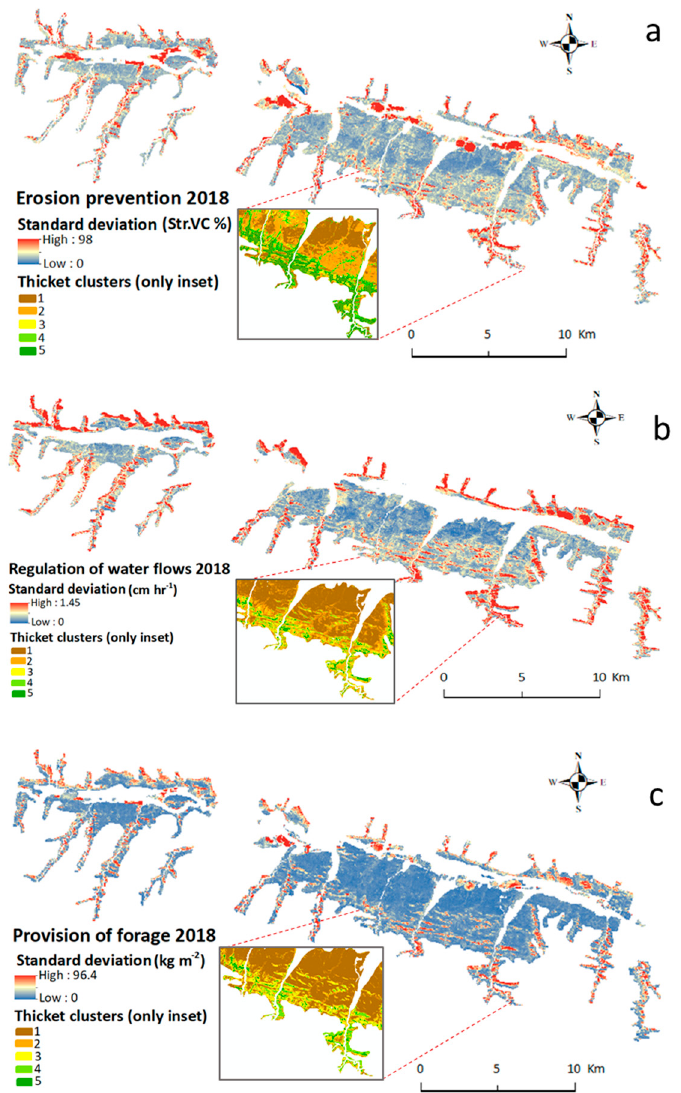
Figure 3. Standard deviation of ( a ) erosion prevention, ( b ) regulation of water flows, and ( c ) provision of forage for the year 2018 at the pixel level (10 m 2 ) in thicket. The inset sections show the spatial distribution of the five trend classes within thicket, each showing different levels of annual variation.